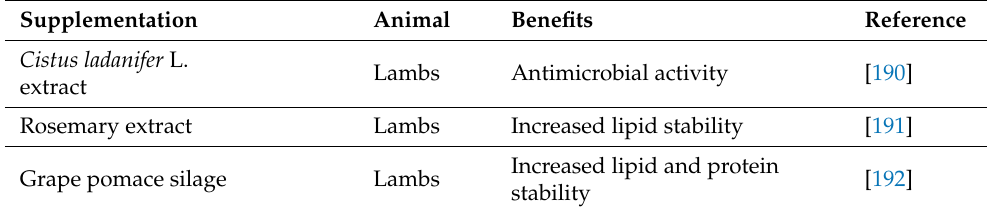
Table 2. Influence of enriched animal diet on meat quality parameters.